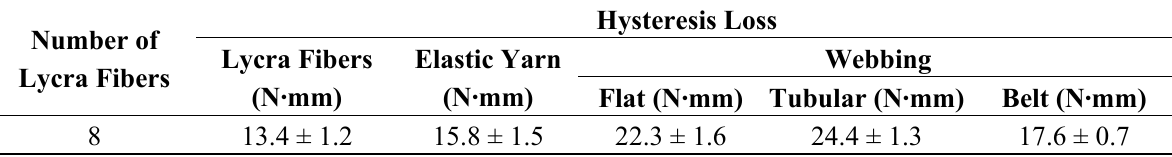
Table 2. Hysteresis loss of webbings during the stretch-recovery measurements at 30% strain.